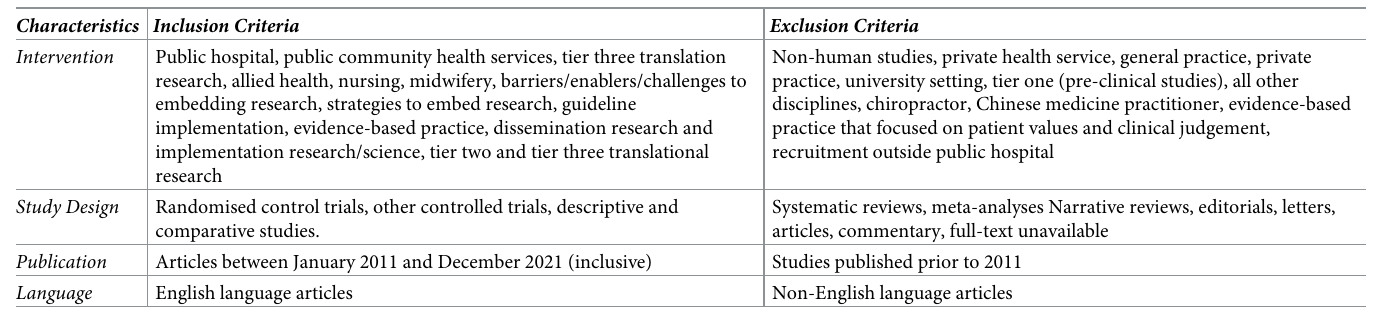
Table 1. Inclusion and exclusion criteria used within the literature search process.